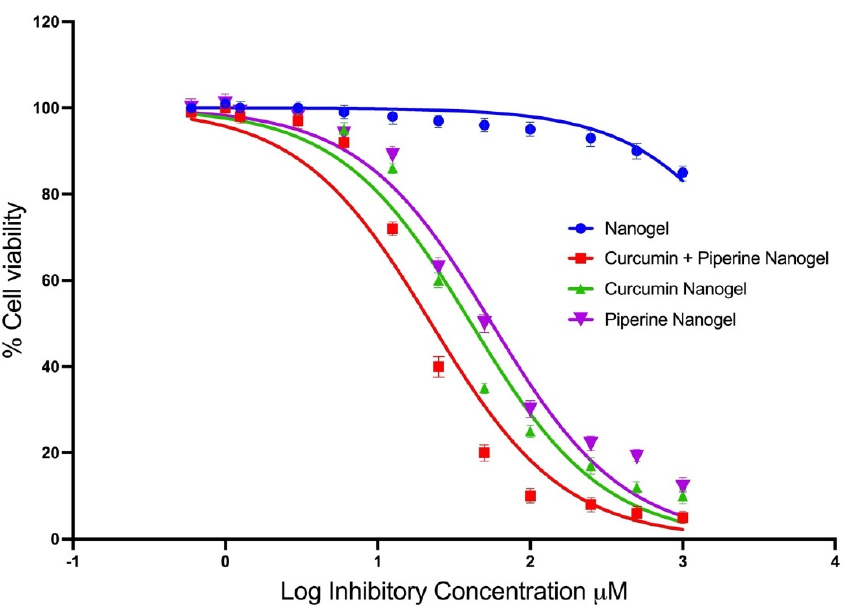
Figure 4. The percentage cell viability of the U-251 MG glioblastoma cells treated with piperine and curcumin-loaded